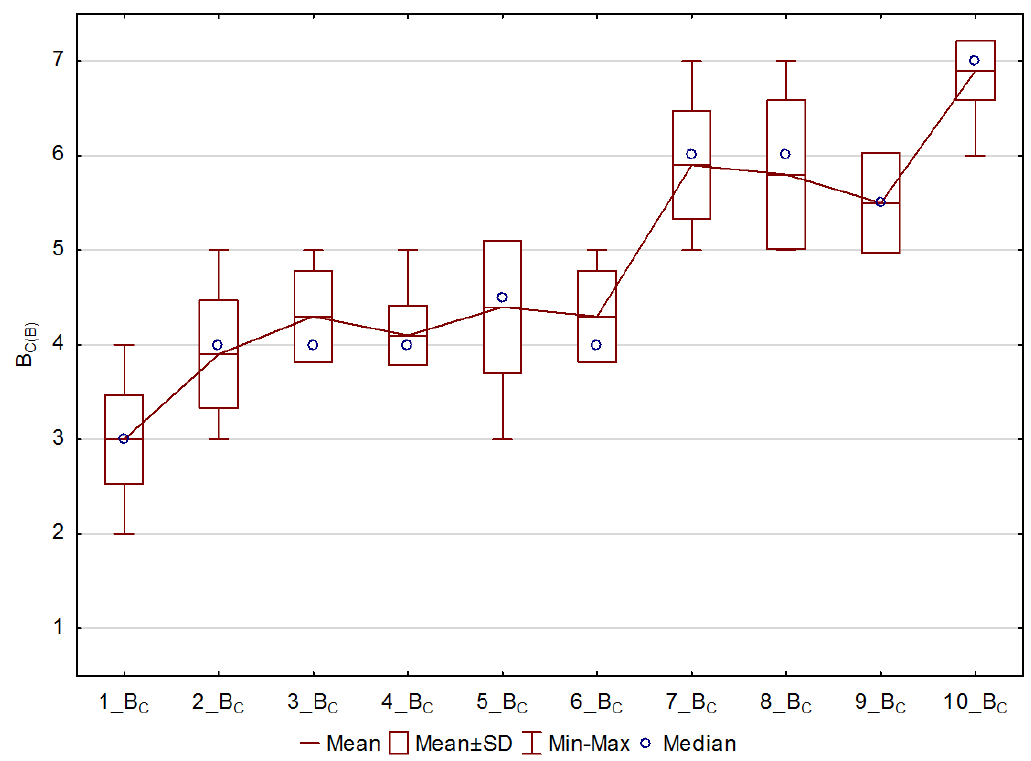
Figure 23. Ceiling brightness perception for group B.